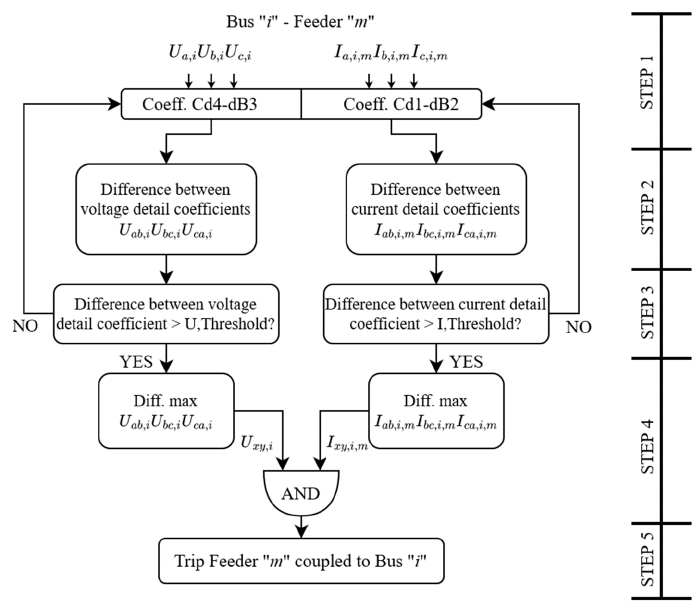
Figure 5. Flowchart of the operational sequence of the protection relay.